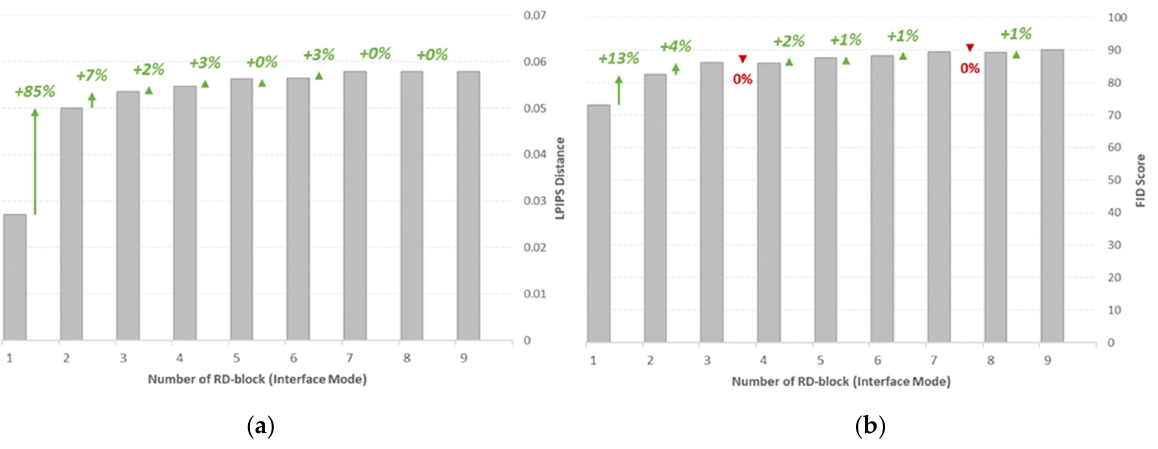
Figure 11. ( a ) LPIPS and ( b ) FID metrics of the synthetic images generated with varying numbers of RD-blocks in inference mode. Performance metrics are also summarized in Table S1.